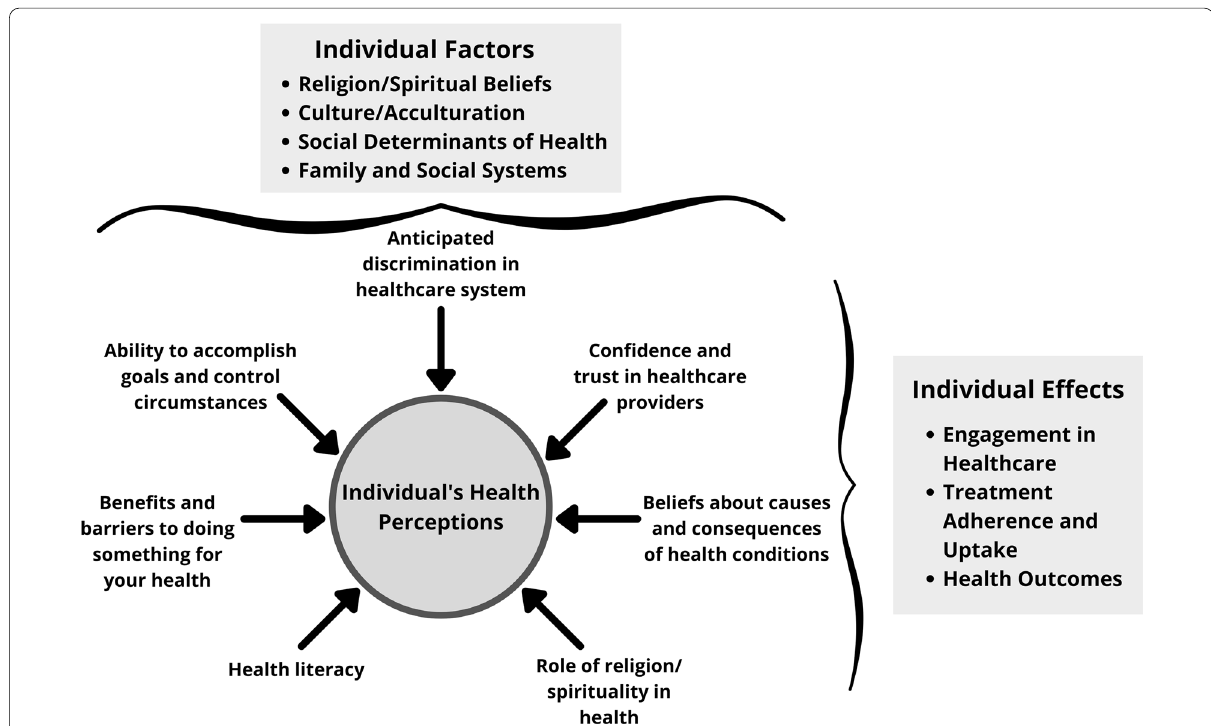
Fig. 1 Multidimensional health perceptions